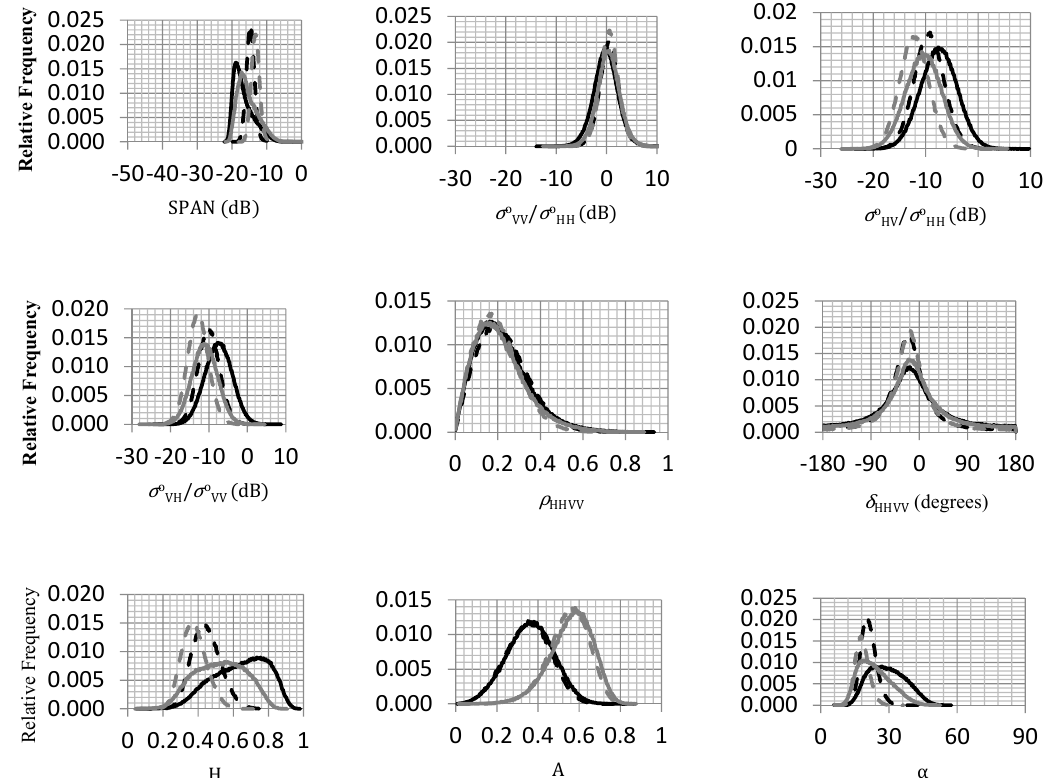
Figure 5. Histograms of polarimetric SAR parameters for the case of ALOS-2 data. Solid line refers to FYI and dashed line refers to OI. Black lines refer to the image acquired on 5 April 2015, while gray lines refer to the image acquired on 28 April 2015.